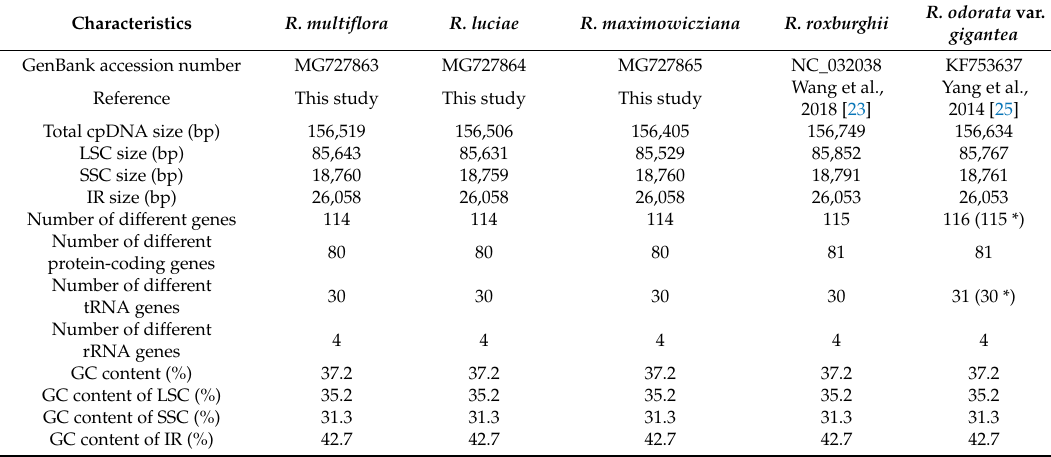
Table 3. The general characteristics of five Rosa chloroplast